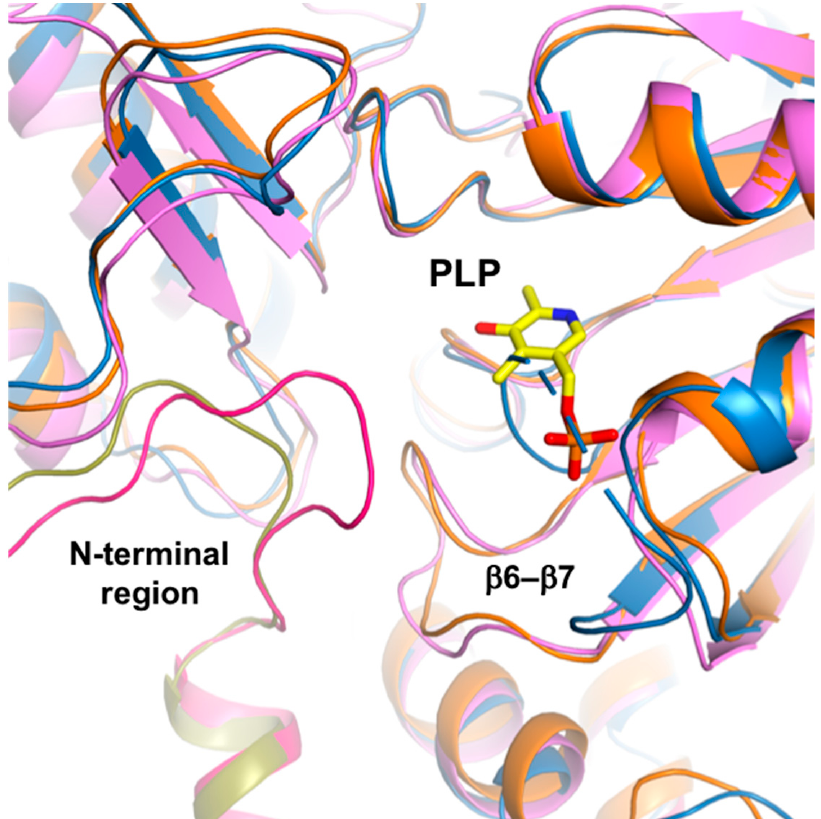
Figure 5. N-terminal comparison. Overlaid structures of Sc PSAT (blue), Se PSAT (pink), and Hs PSAT-PLP complex (orange). While the N-terminal conformation of ScPSAT is disordered, those of Se PSAT and the Hs PSAT-PLP complex are shown in magenta and olive colors, respectively. PLP-bound in Hs PSAT is colored yellow.